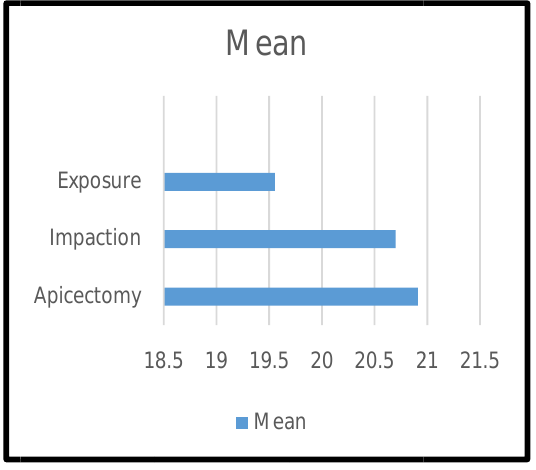
Figure13: time of surgery in each DISCUSSION